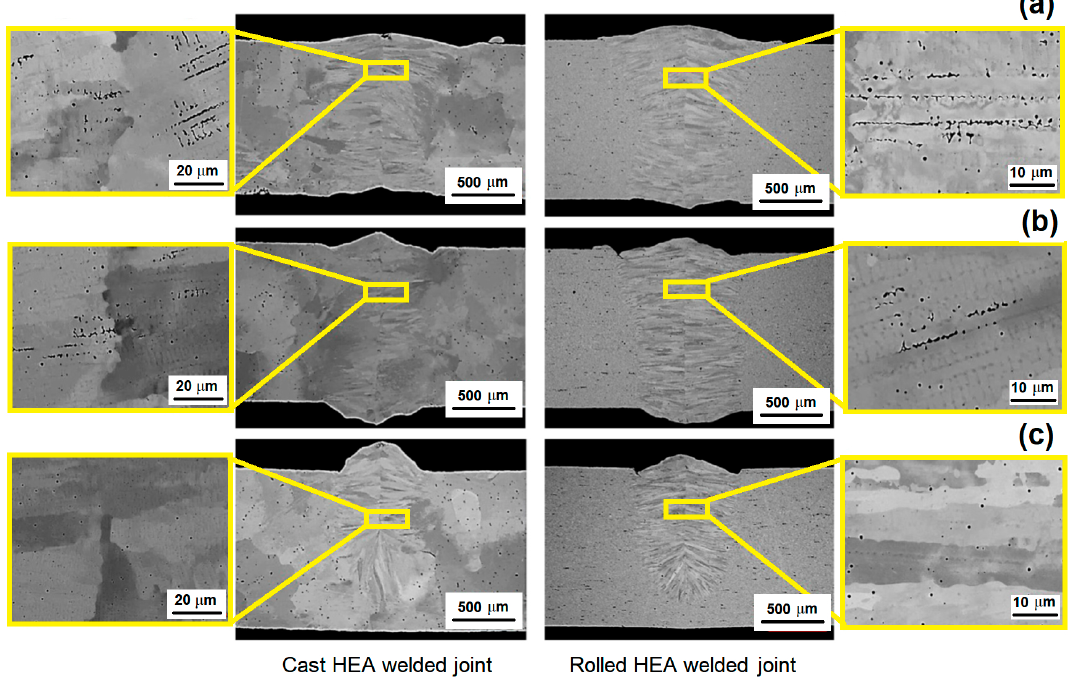
Figure 2. Comparison of the welding microstructure of the CoCrFeMnNi alloy as cast (left) and rolled (right). Samples welded by LBW in different velocities ( a ) 6 m min − 1 , ( b ) 8 m min − 1 , and (c) 10 m min − 1 . Adapted from [26].